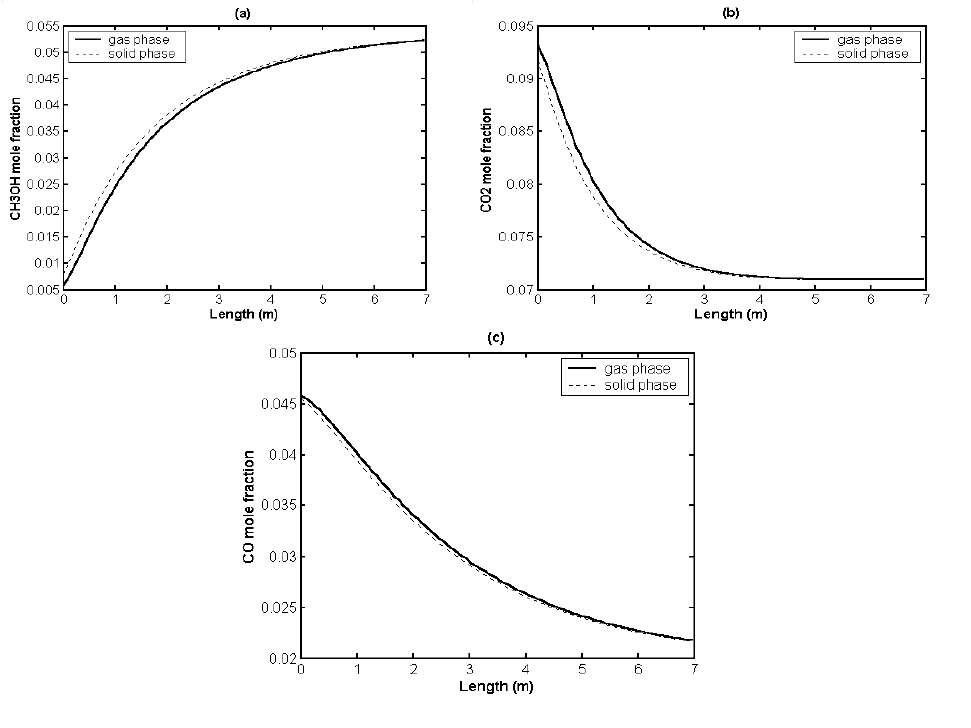
Figure 1. Variation of methanol (a), carbon dioxide (b), and carbon monoxide (c) mole fractions along the reactor length.